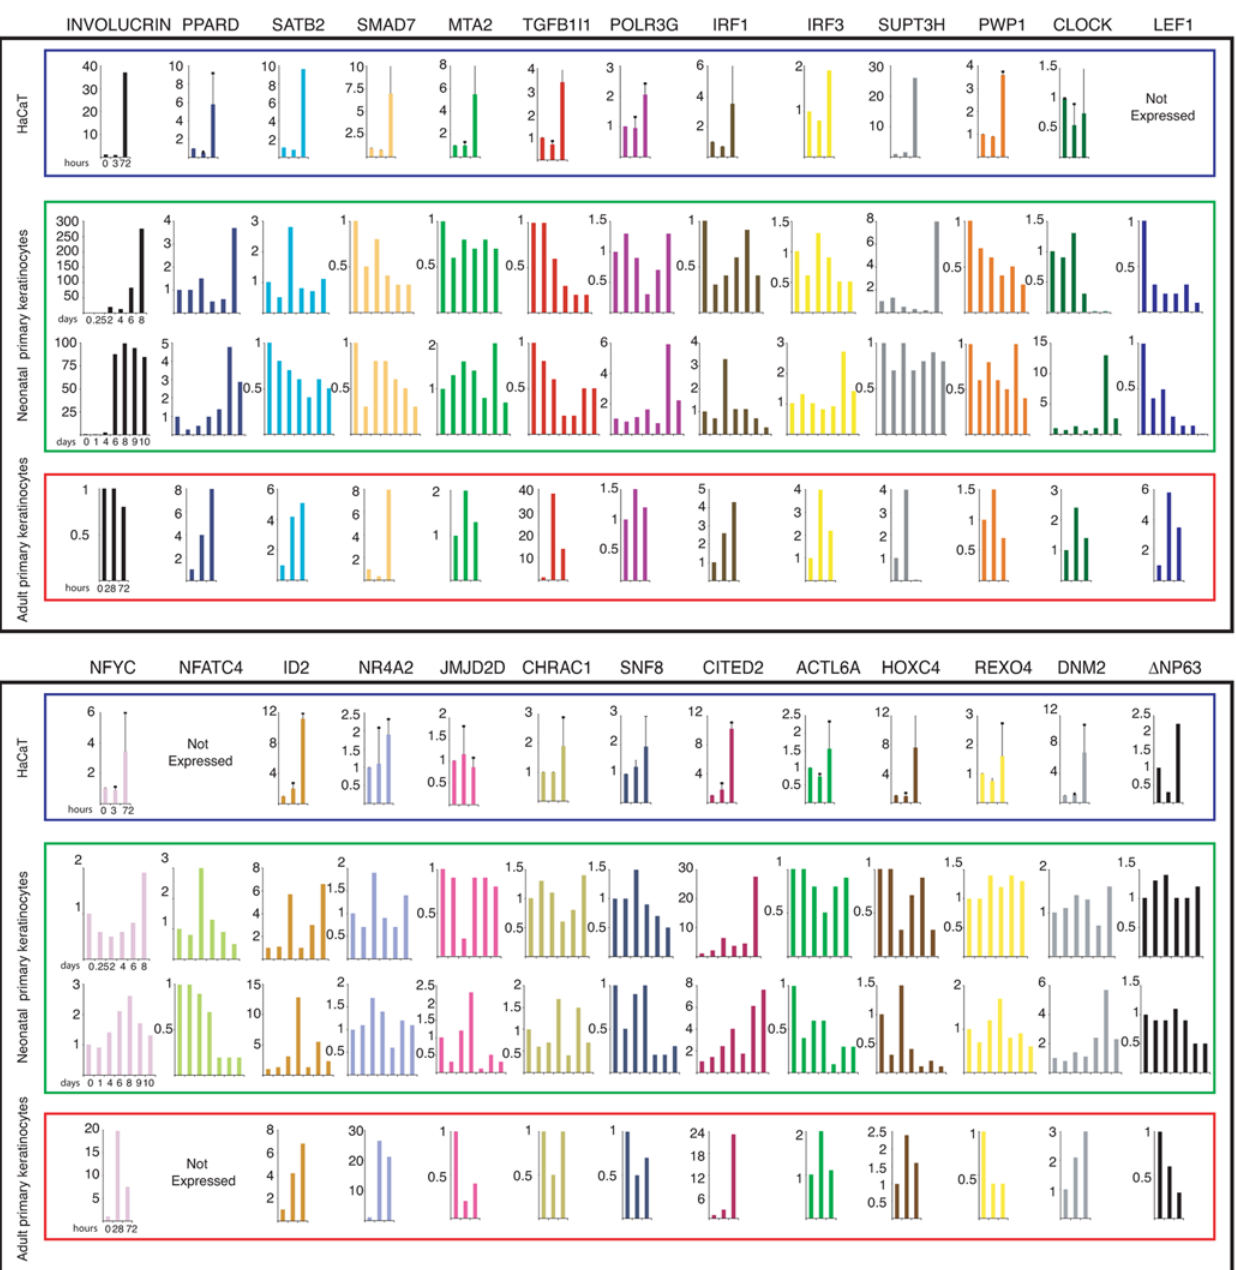
Figure 2. Summary of the validating assays for the 36 transcriptional regulators targeted by p63. The results of the ChIPs on the different selected genomic regions are indicated as positive (pos) when fold enrichment over flag was . 2, weak positive (wp) when 1 , fold enrichment , 2 or negative (neg) if fold enrichment , 1. nt = not tested. Expression fold changes are indicated with an upward red arrow if the gene was upregulated in the sip63 HaCaT sample or a downward green arrow if the gene was downregulated. The size of the arrow is indicative of the amount of the fold change: thin for changes , 20% and thick for changes . 20%. nc = no change. For the overexpression studies the same representation is depicted with the addition of 2 different time points for the D Np63 a overexpression in U2OS and the induction of SAOS; the small t indicates a transient change of expression. For HaCaT and APHK only the D Np63 a overexpression is considered. The + sign in the ChIP data column indicates the presence of the gene in the binding data of [9]. The arrowheads in the other sip63 experiments column indicate expression changes in the cited datasets: a [11], b [33], c [34], d [32], e [12] and f [9].